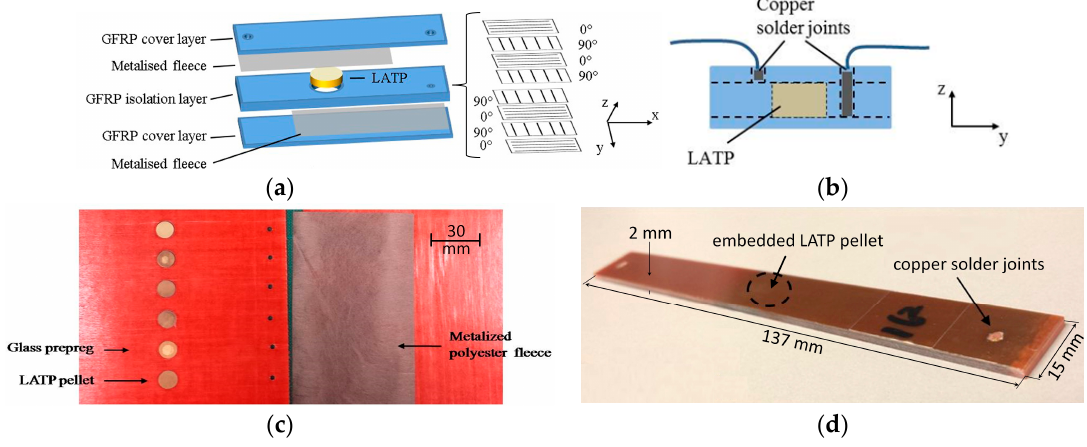
Figure 4. ( a ) Architecture of the LATP–GFRP composite; ( b ) electrical connectors; ( c ) core laminate with embedded LATP pellets; ( d ) four-point bending test specimen with bond points for electrical